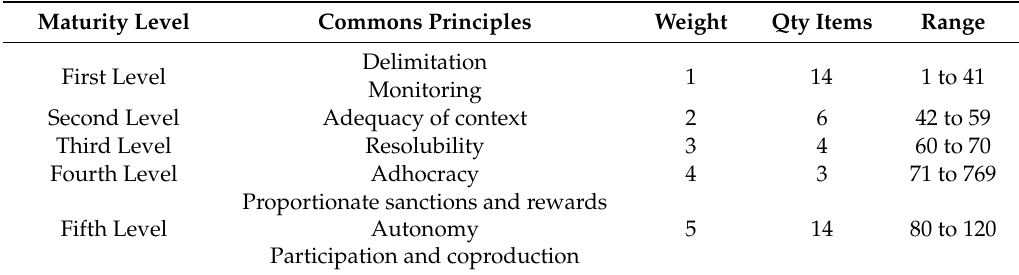
Table 9. MEPA commons dimension weights and maturity